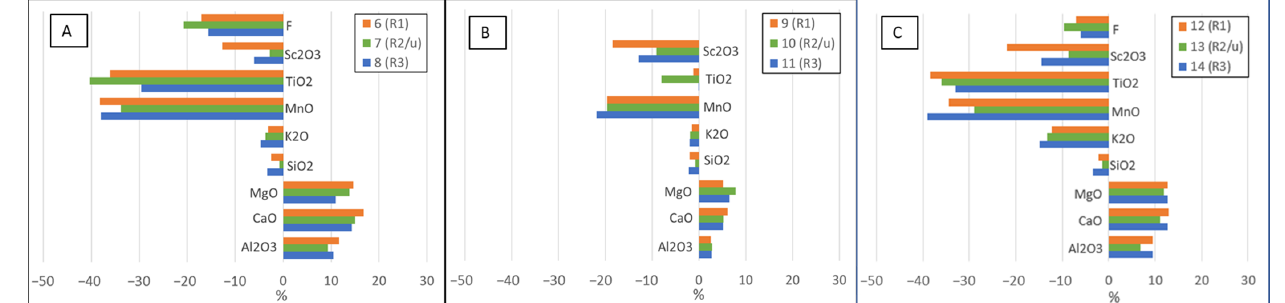
Figure 6. Differences between the analyzed (EPMA) and calculated (ICP-OES) slag compositions. Experiments using concentrates R1, R2/u, and R3 with ( A ) 7% CaF 2 , ( B ) 5% CaO, and ( C ) 7% CaF 2 + 5% CaO.